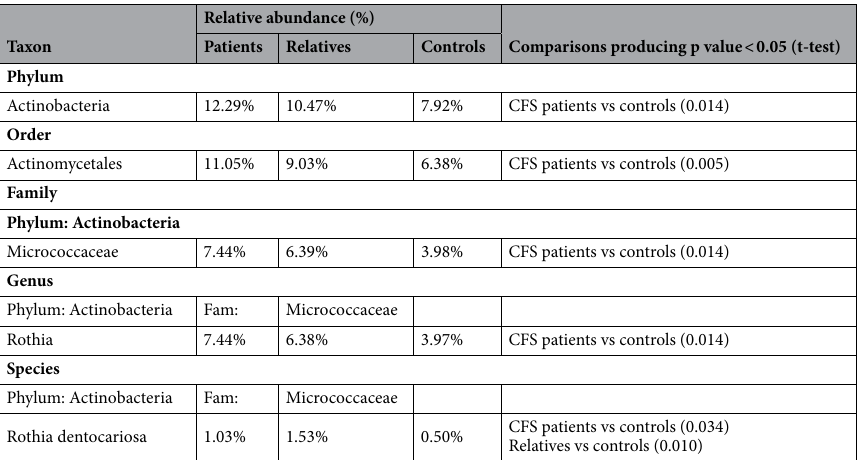
Table 5. Significant differences in bacterial taxa abundances in salivary samples of the three experimental groups. The relative abundances are reported as average abundance values of each group. Student’s two-tailed t-test and post hoc Bonferroni correction were applied to determine any significant difference in the relative abundances of oral bacterial taxa between groups.